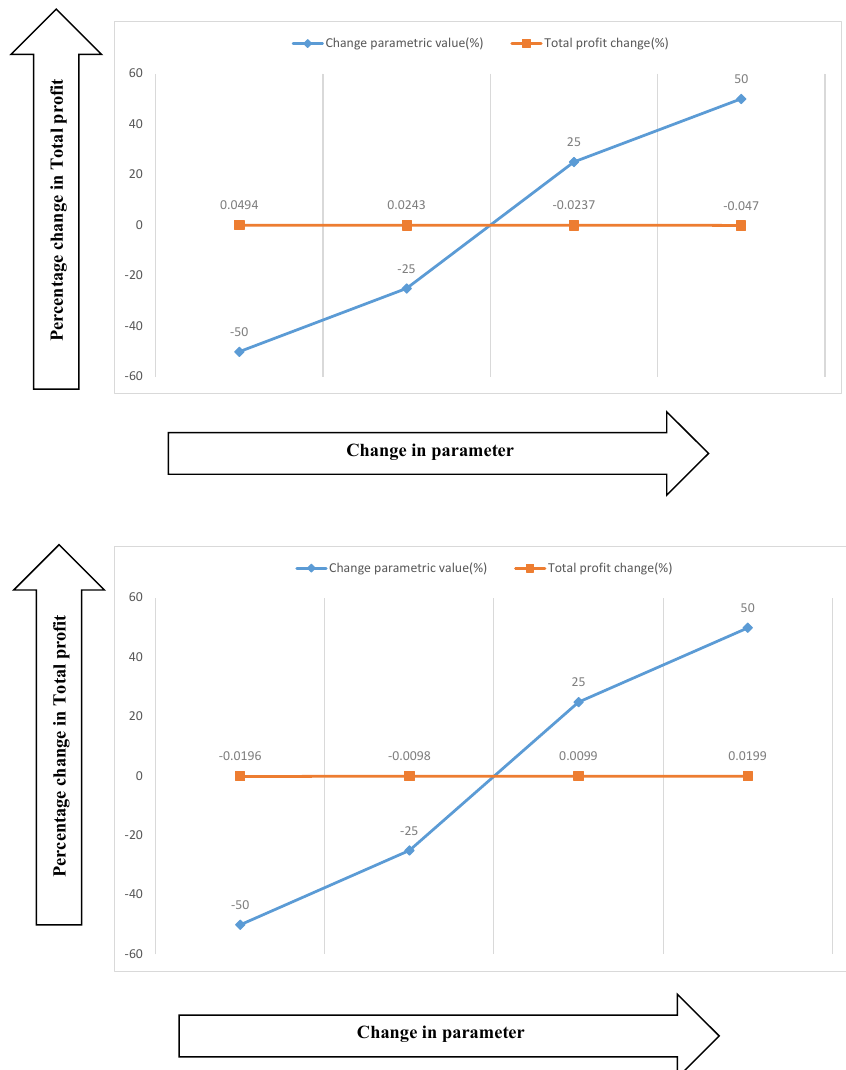
Figure 8. Changes in parameters C q and τ versus percentage change in total profit, respectively.